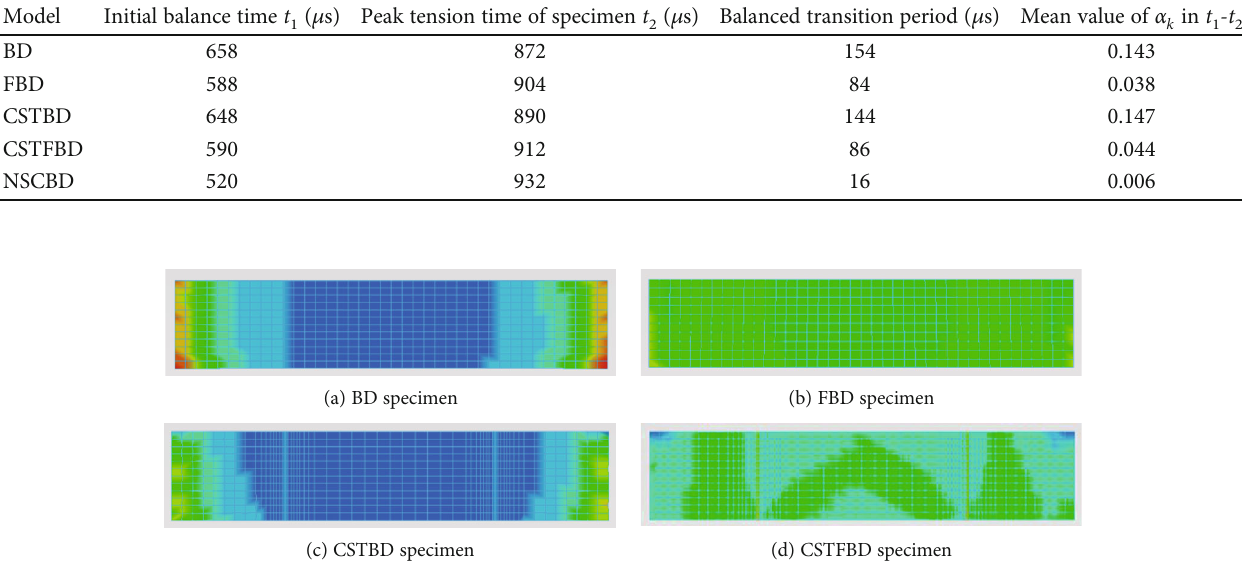
Figure 16: Equivalent stress distribution on the section of the loaded diameter